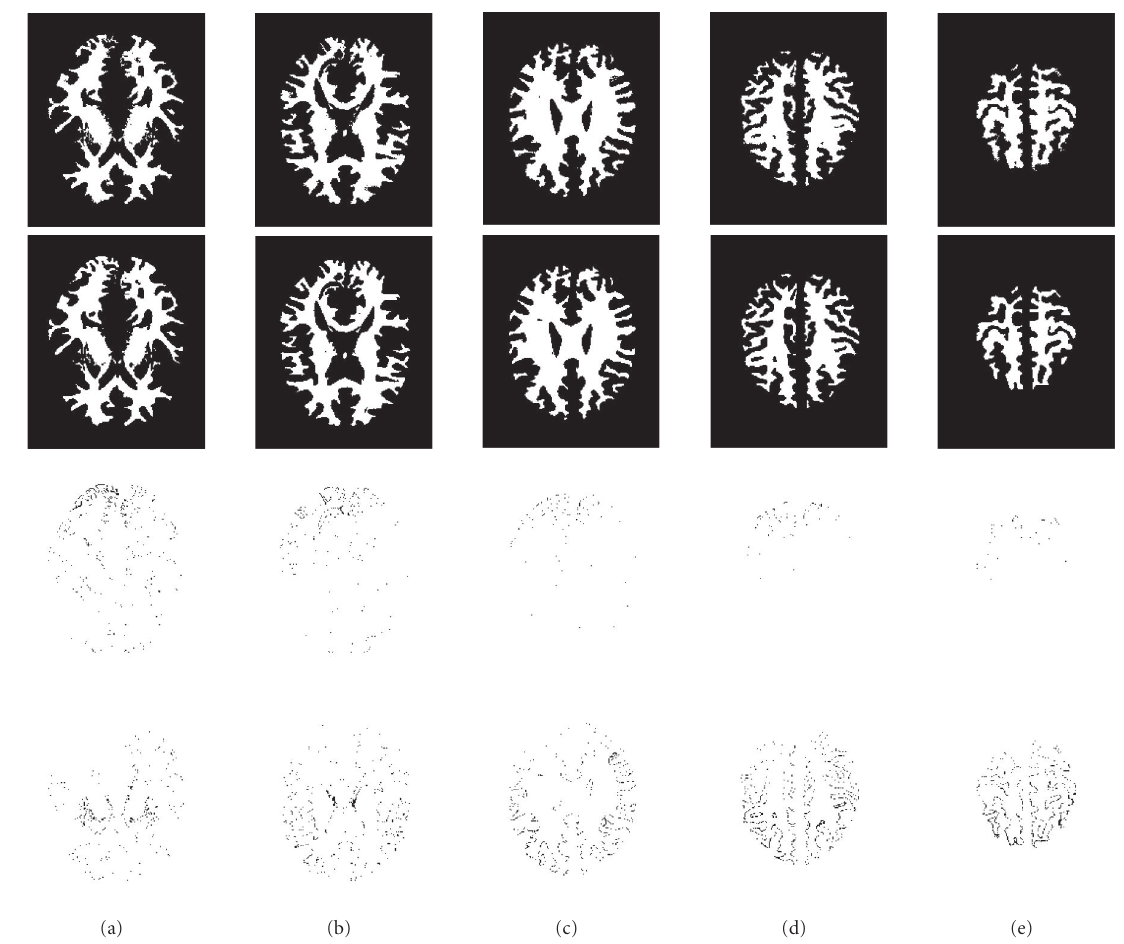
Figure 8: Comparison of the segmentation results from our method with the ground truth data of five slices of one 3D simulated brain image provided by BrainWeb [52], which is of T1 modality, 1mm slice thickness, 3% noise level, 20% INU. The image size is 181 × 217 × 181. The top row presents the segmentation results obtained from our method. The second row shows the ground truth data provided by BrainWeb database. The third row shows the false negative di ff erence between the segmentation results from our method and the ground truth data. The fourth row shows the false positive di ff erence between the segmentation results from our method and the ground truth data. These five columns correspond to five slices of the test 3D